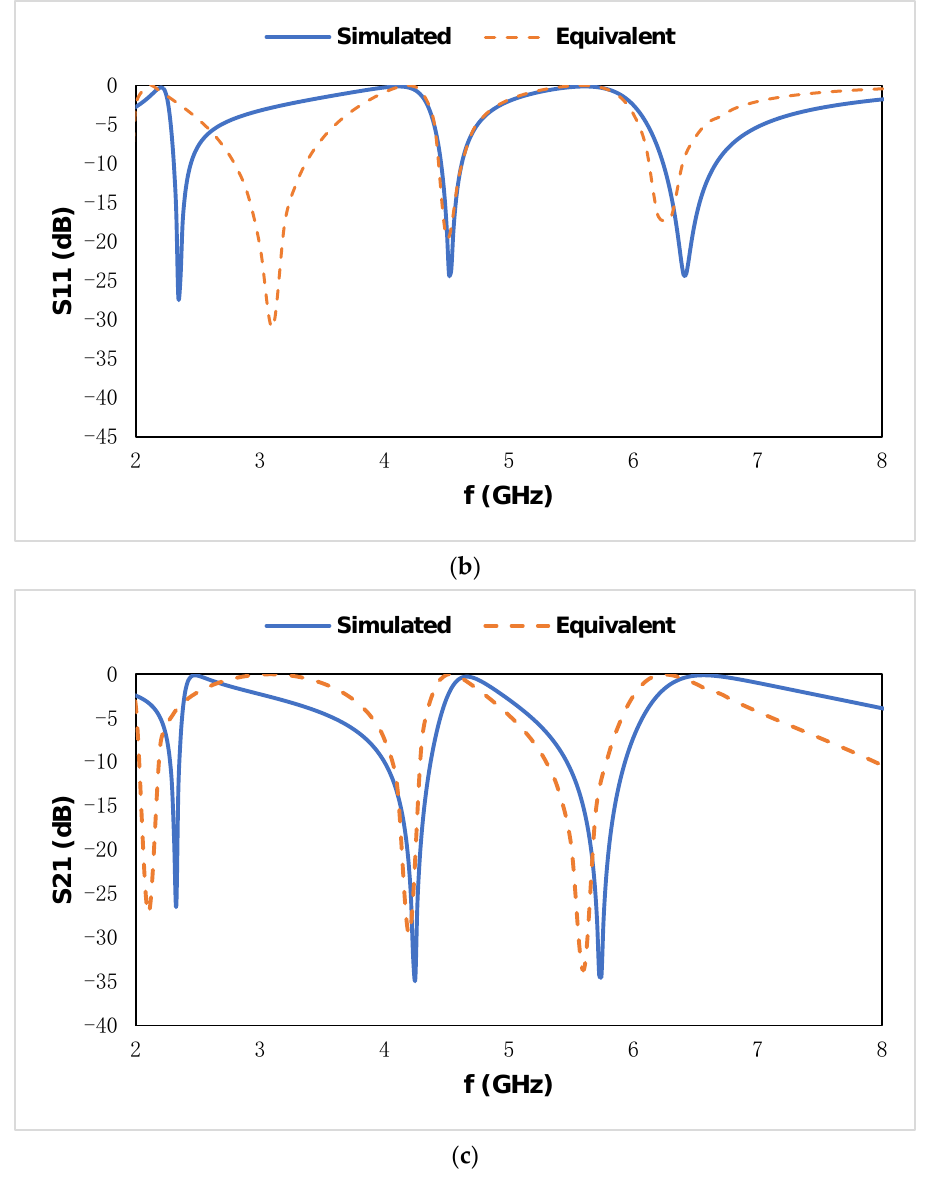
Figure 6. Equivalent circuit model with lumped elements ( a ) and the corresponding results of reflection coefficient ( b ) and transmission coefficient ( c ).